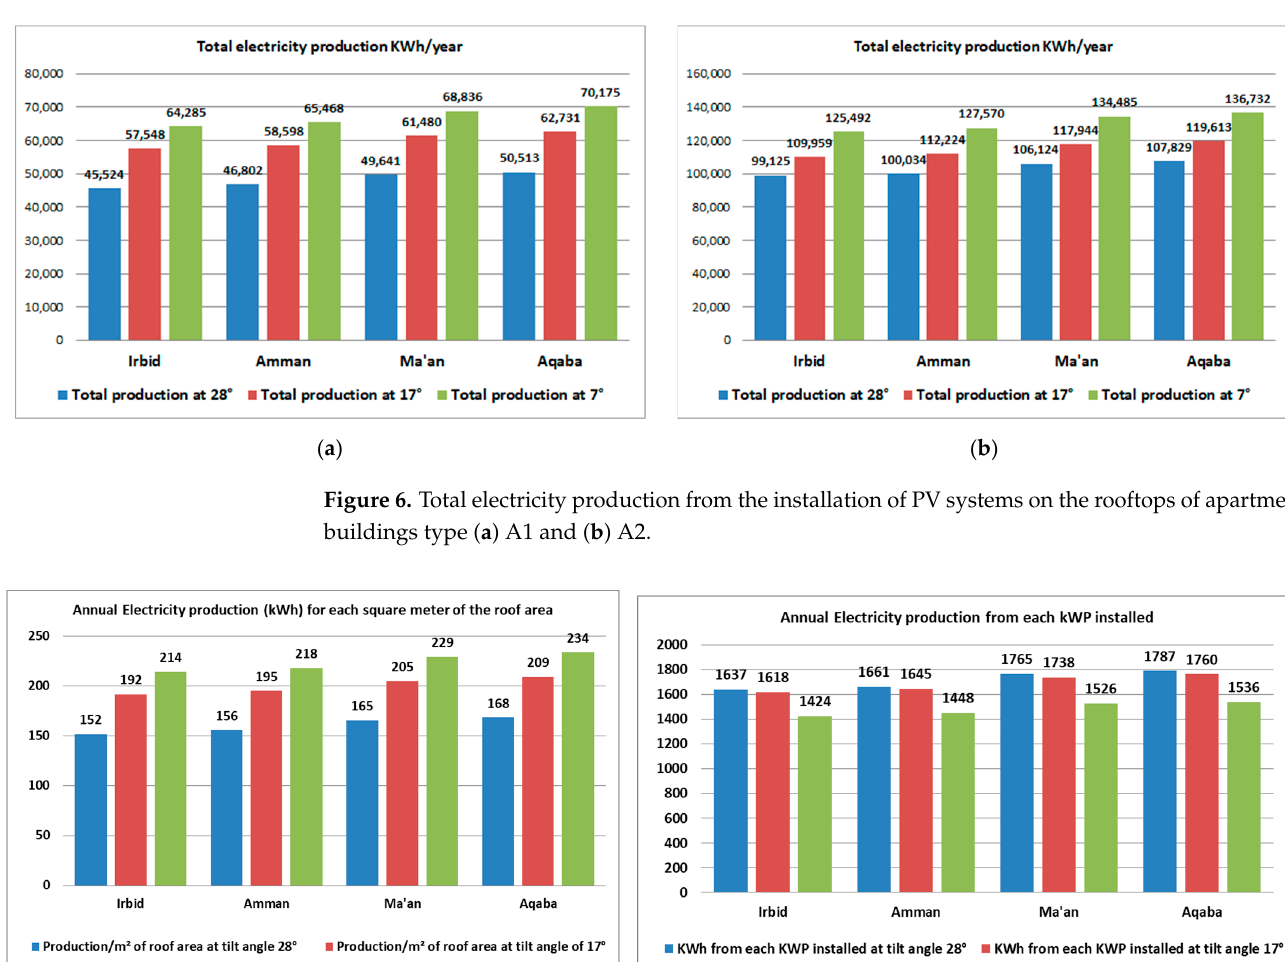
Figure 5. Total electricity production from the installation of PV systems on the rooftops of ( a ) single houses and ( b ) villas.